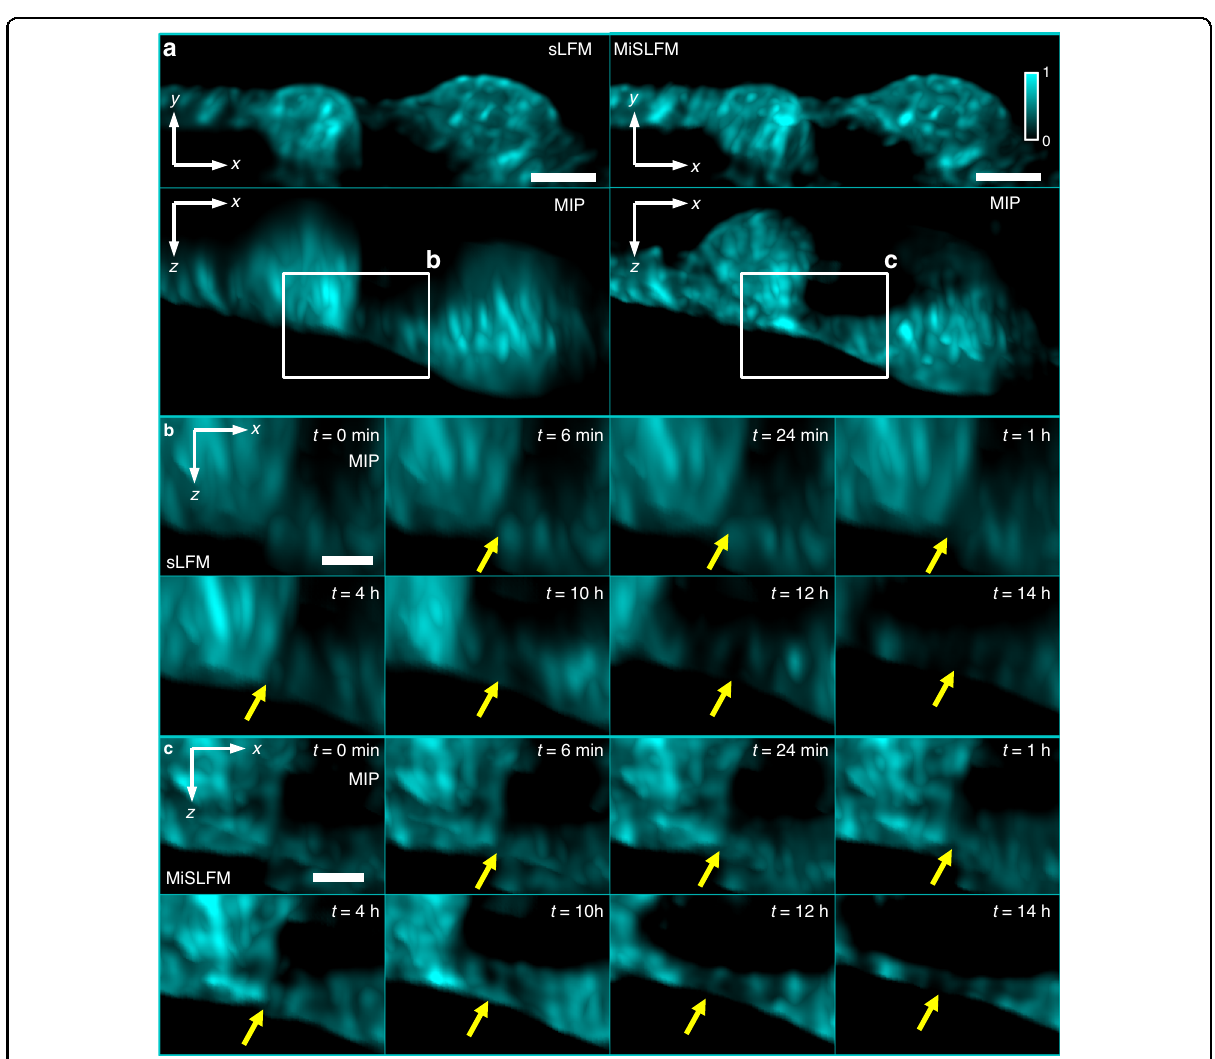
Fig. 3 Long-term volumetric imaging of B16-GFP cells under extremely low light. a MIPs of the reconstructed membrane (cyan, 488 nm), at 6-min intervals (illumination time of 2.25 s) and up to 14 h of recording for sLFM and MiSLFM under 0.22 mW mm − 2 illumination, demonstrating low photobleaching and phototoxicity for MiSLFM. b , c Magni fi ed areas marked by white boxes in ( a ), by sLFM ( b ), and MiSLFM ( c ). Yellow arrows mark the cell membrane contact of two cells, which shows the superior axial resolution of MiSLFM and indicates that two cells maintain cell viability after 14 h of imaging. Scale bars in ( a ) is 10 µm, in ( b ) and ( c ) are 5